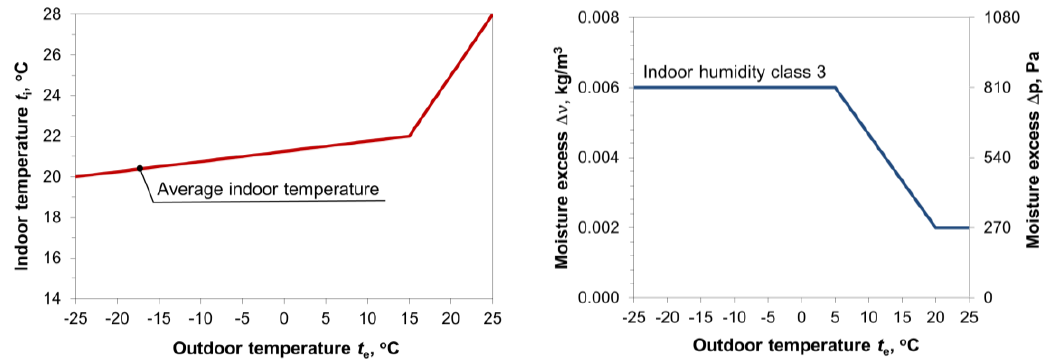
Figure 4. Dependence of indoor temperature ( left ) and design value of moisture excess ( right ) on the outdoor temperature.